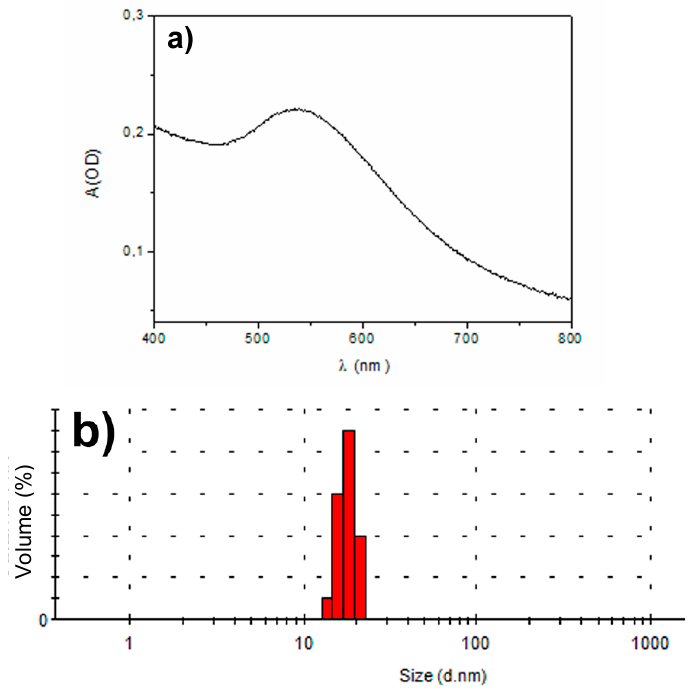
Figure 2. Characterization of Au-3MPS nanoparticles in water: ( a ) UV-vis spectrum; ( b ) DLS data. Materials 2017 , 10 , 258